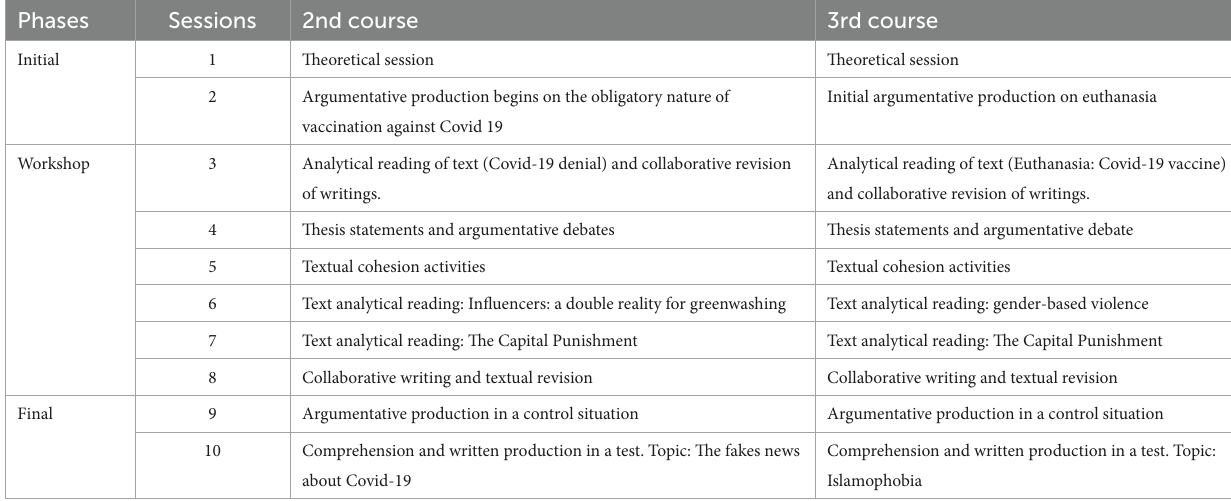
TABLE 3 Didactic intervention